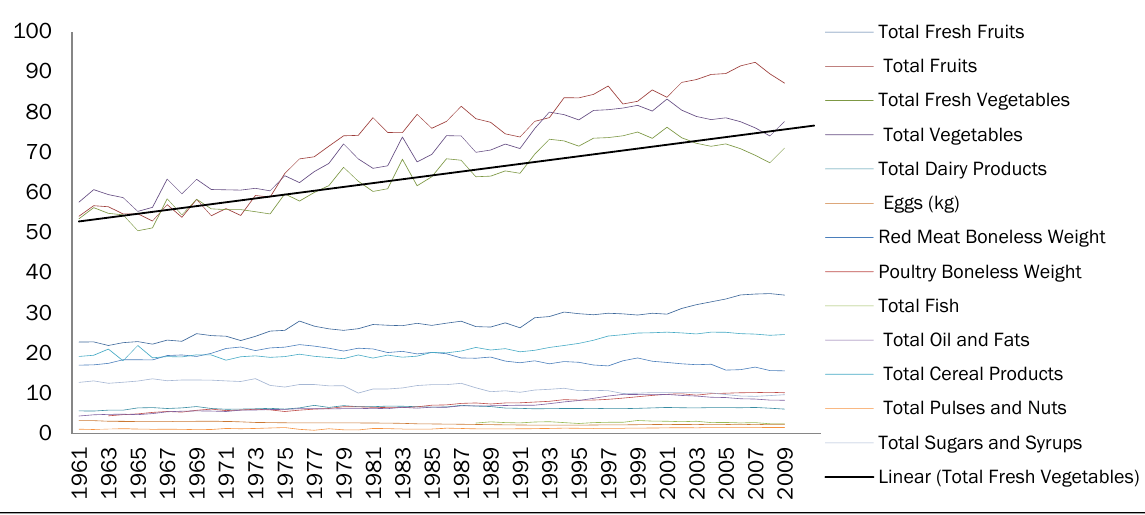
Figure 2. Food Waste per Person per Year per Food Category